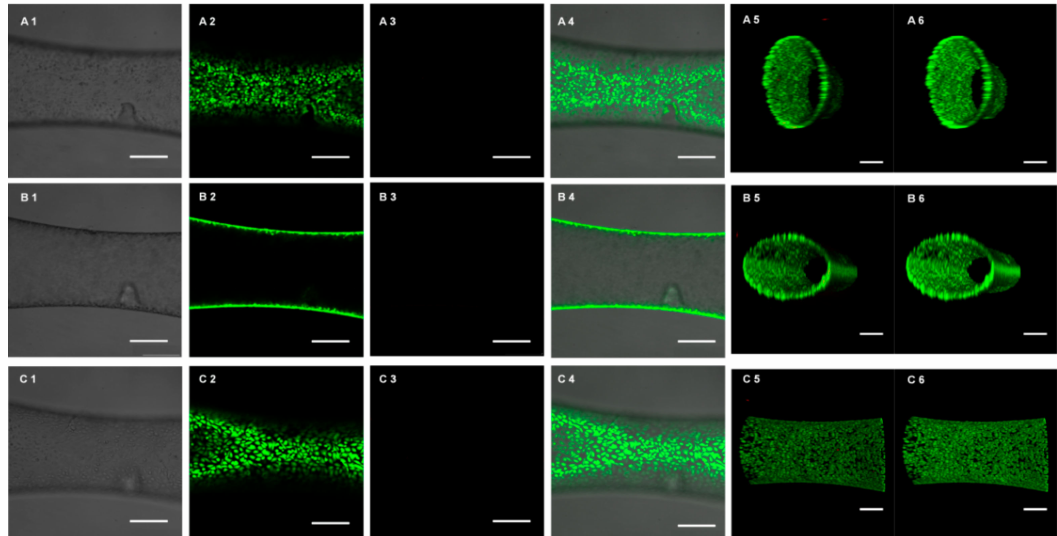
Figure 4. Calcein-AM and PI double staining, showing the endothelialized cell survival results of microvessels in the microfluidic chips. Confocal fluorescence microscopy images, showing the bottom ( A1 – A4 ), cross-section ( B1 – B4 ), and top ( C1 – C4 ) views of the microvessels in the deformation section of a channel with a smallest diameter of 390 µ m. 1 for optical image; 2 for Calcein-AM staining; 3 for PI staining; 4 for merged image. Scale bar, 250 µ m. 3D reconstruction views of the microvessels with HUVECs (A5–C5, A6–C6). ( A5 , A6 ) Top view of the microvessel with HUVECs; ( B5 , B6 ) One side angle view of the microvessel with HUVECs; ( C5 , C6 ) Side view of the microvessel with HUVECs. (A5–C5) stained by Alexa Fluor ™ 488 Phalloidin and DAPI nucleic acid double staining, (A6–C6) stained by DAPI nucleic acid staining. Scale bar, 200 µ